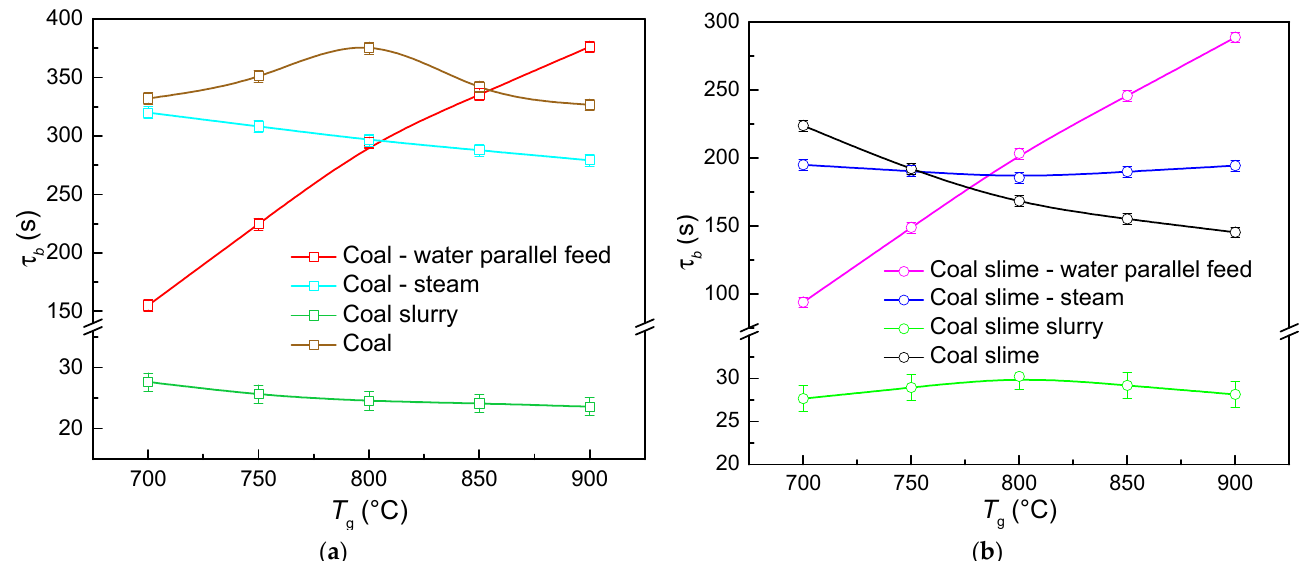
Figure 8. Combustion duration of fuels based on bituminous coal ( a ) and coal slime ( b ) when varying the method of introducing the components and temperature in the combustion chamber.